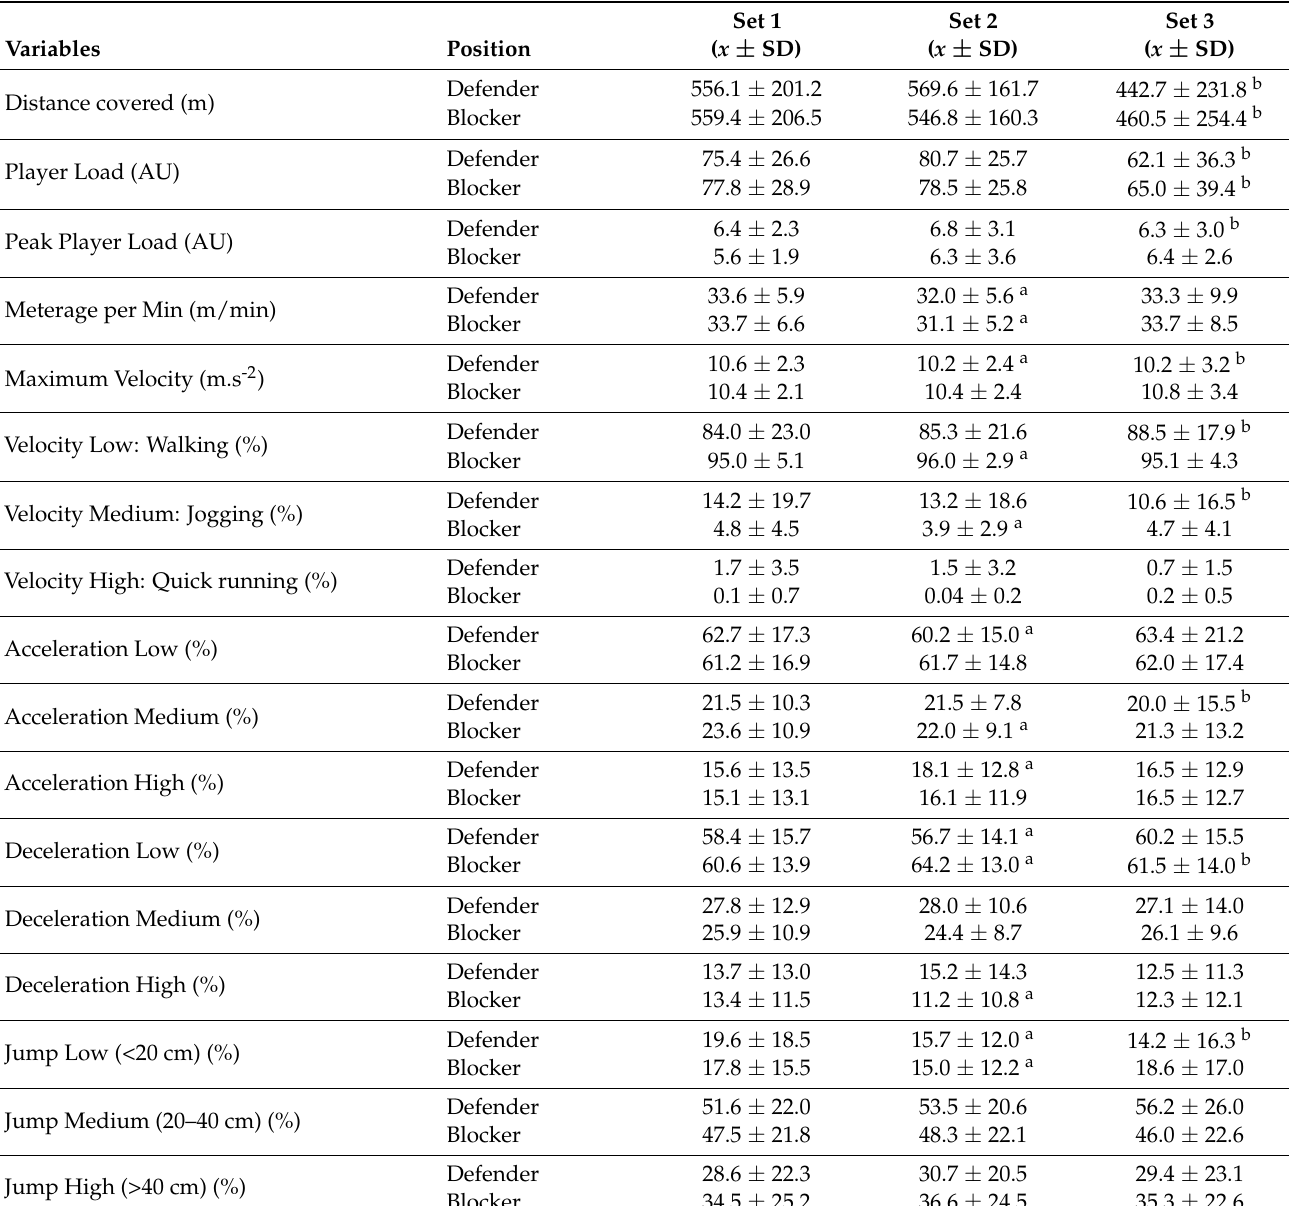
Table 3. Descriptive statistics ( x ± SD) and comparison of GPS variables according to player position and set in female beach